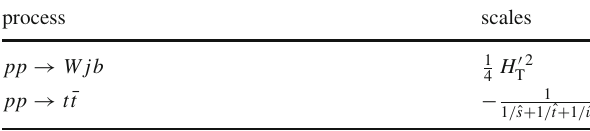
Table 2 Scale choices for W +jets and top-pair production process